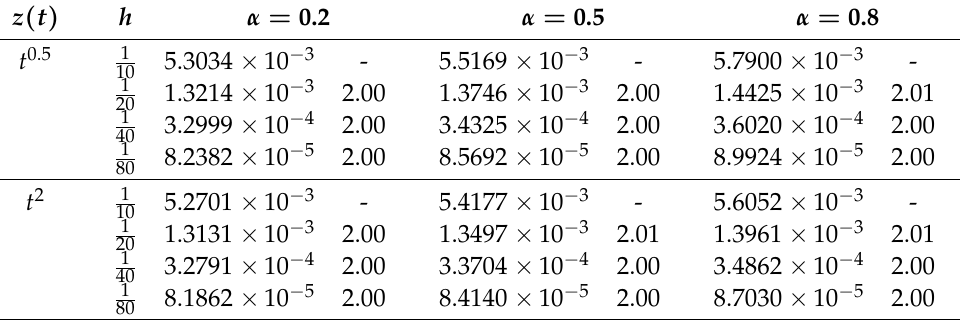
Table 3. (Example 1) Spatial convergence order for various α when N =